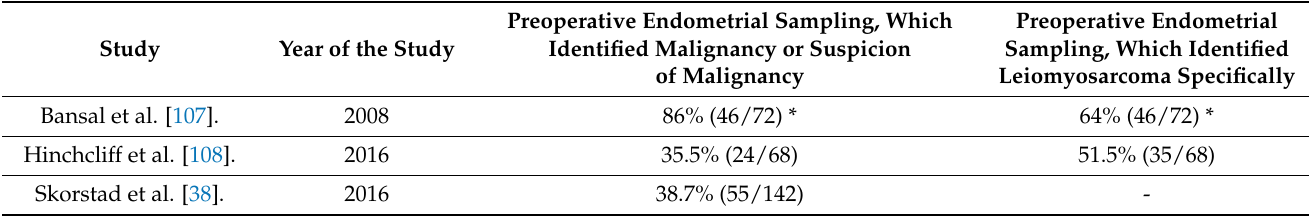
Table 5. The effectiveness of endometrial sampling in ULMS